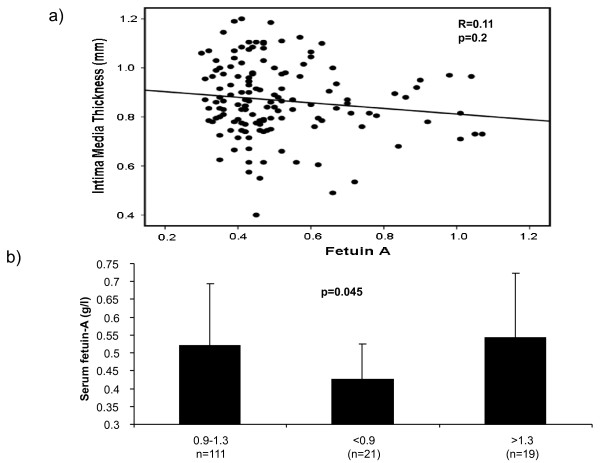
A: Serum fetuin-A levels and macrovascular disease (Intima Media Thickness). Scatter plot showing the relationship between serum fetuin-A levels and IMT. Data as given by Spearman correlation coefficient. B: Serum fetuin-A levels and ankle-brachial index (ABI). Fetuin-A levels were compared between groups stratified by ABI.(< 0.90, 0.90-1.30, and > 1.30). Data +/-SD, p-value as given by one- way ANOVA.